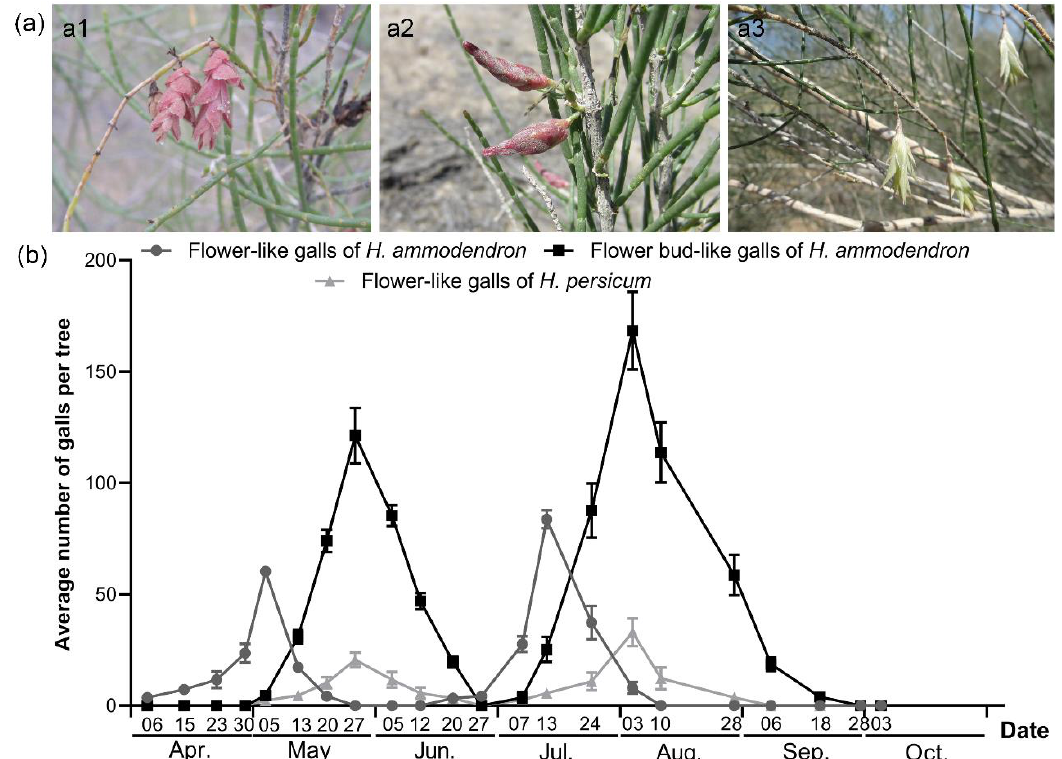
Figure 2. The types ( a ) and occurrence ( b ) of flower-like galls on Haloxylon in Fukang, Xinjiang. ( a1 ) The flower-like gall on H. ammodendron ; ( a2 ) The flower bud-like gall on H. ammodendron ; ( a3 ) The flower-like gall on H. persicum .